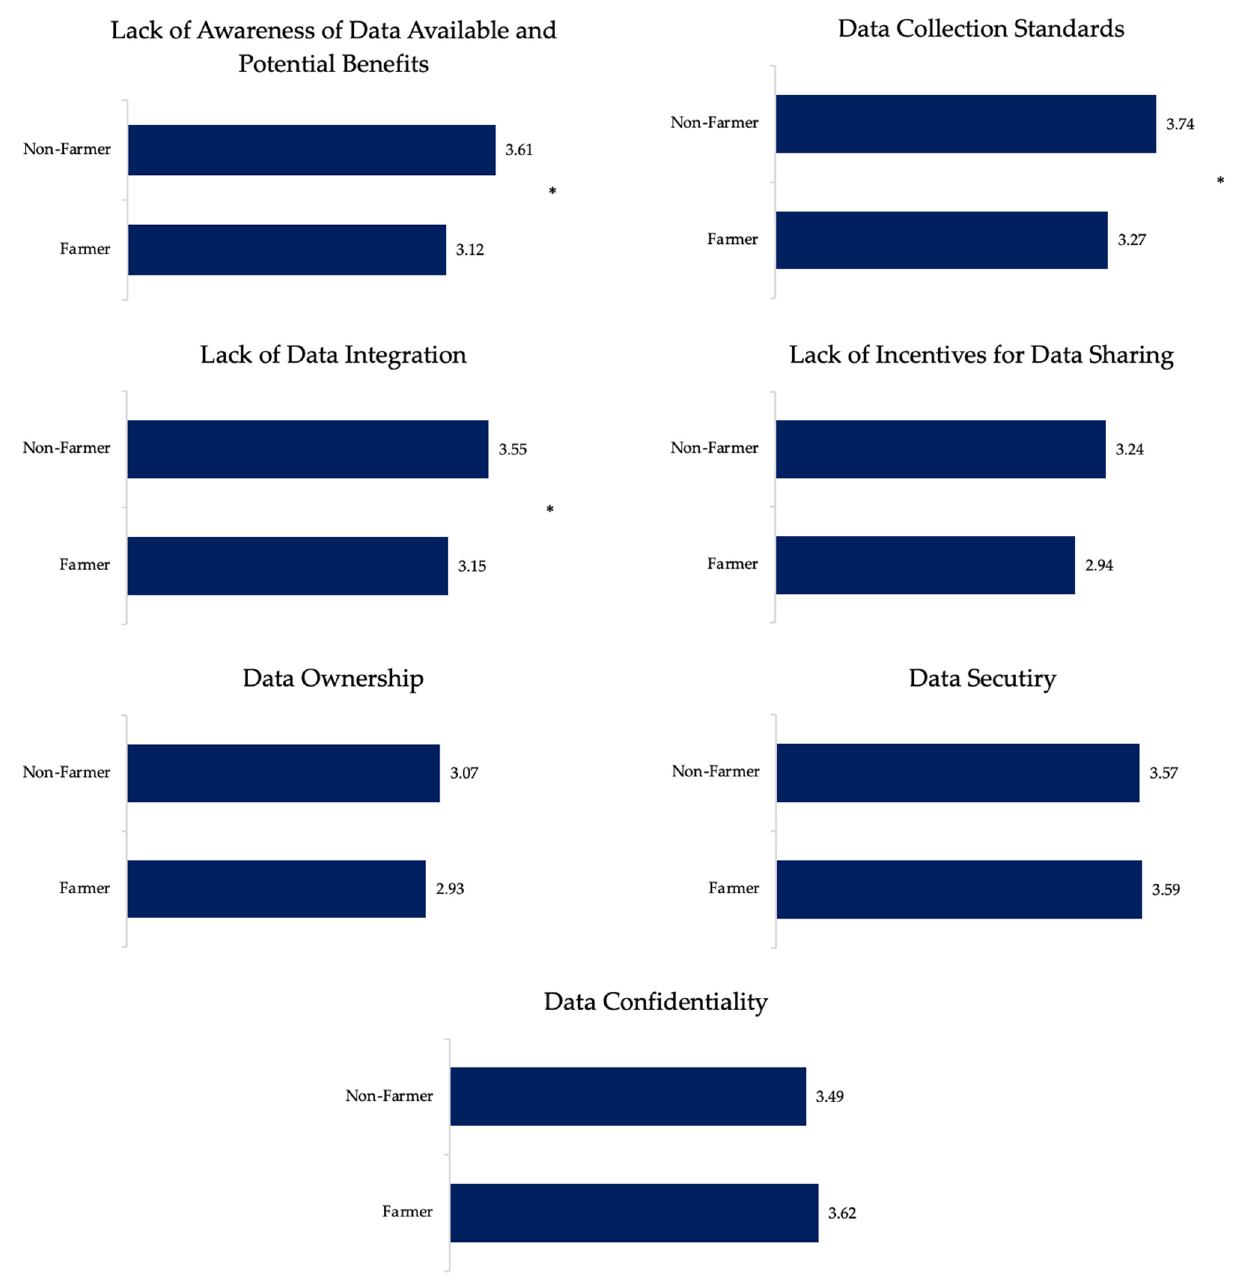
Figure 4. How concerned farmers and non-farmers are about different data management challenges. Level of concern was ranked from 1 to 5, where 1 was ‘not concerned at all’ and 5 was ‘extremely concerned’. The numbers represent the mean sentiment score of farmers and non-farmers of each data management challenge and significant differences (* p < 0.05) are indicated.